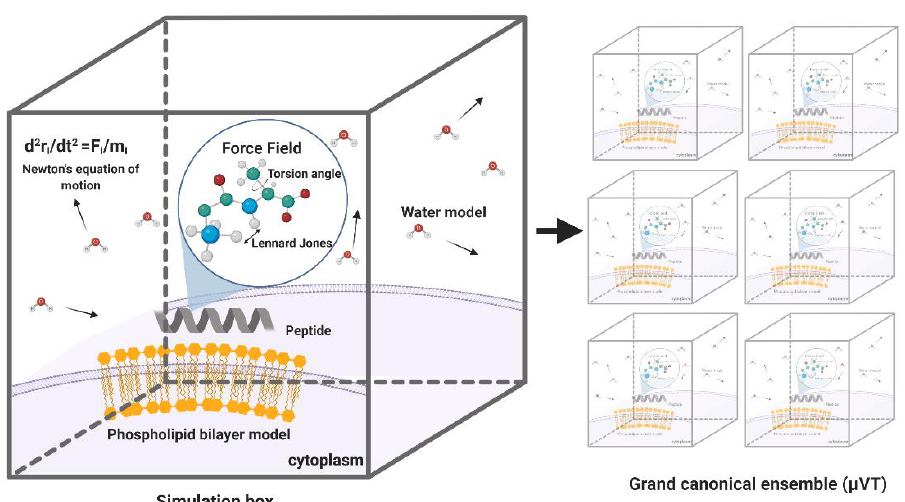
Figure 2. Representation of a traditional membrane-protein system used in molecular dynamics. The interaction among the components is modeled through force fields that account for variations in key parameters and impose restrictions on the accessible states (Created with BioRender).